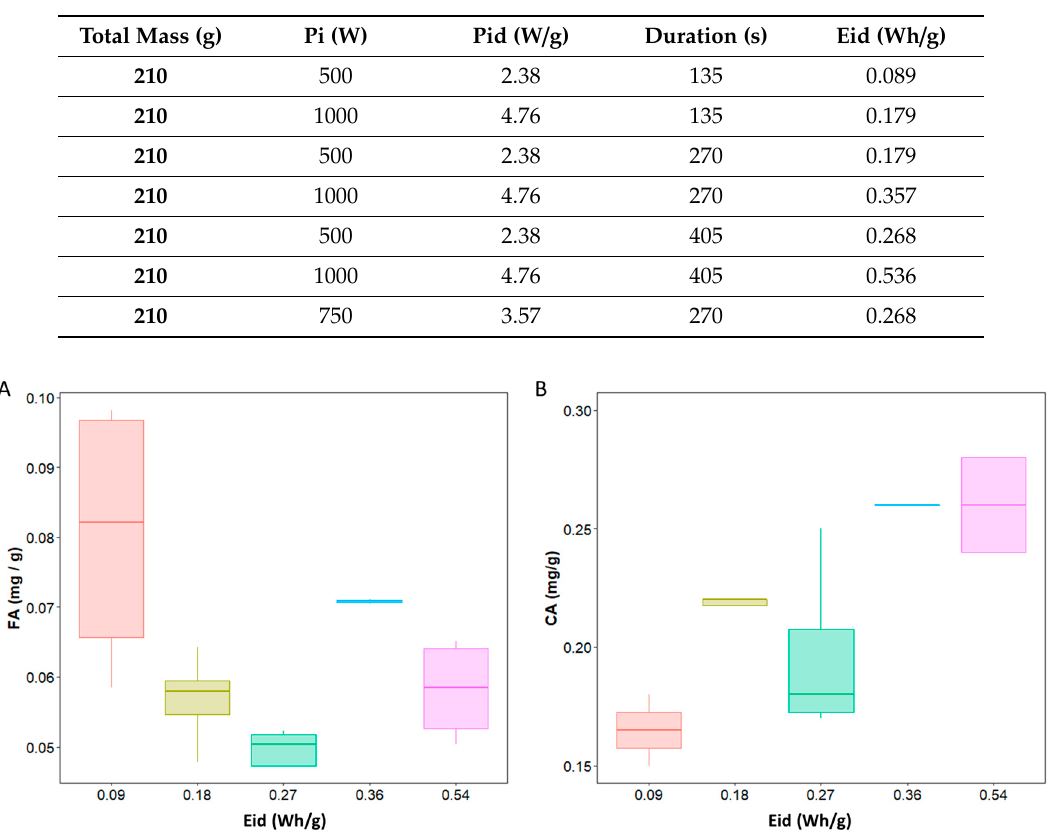
Figure 5. Ferulic ( A ) and coumaric ( B ) acids release depending on incident energy density.